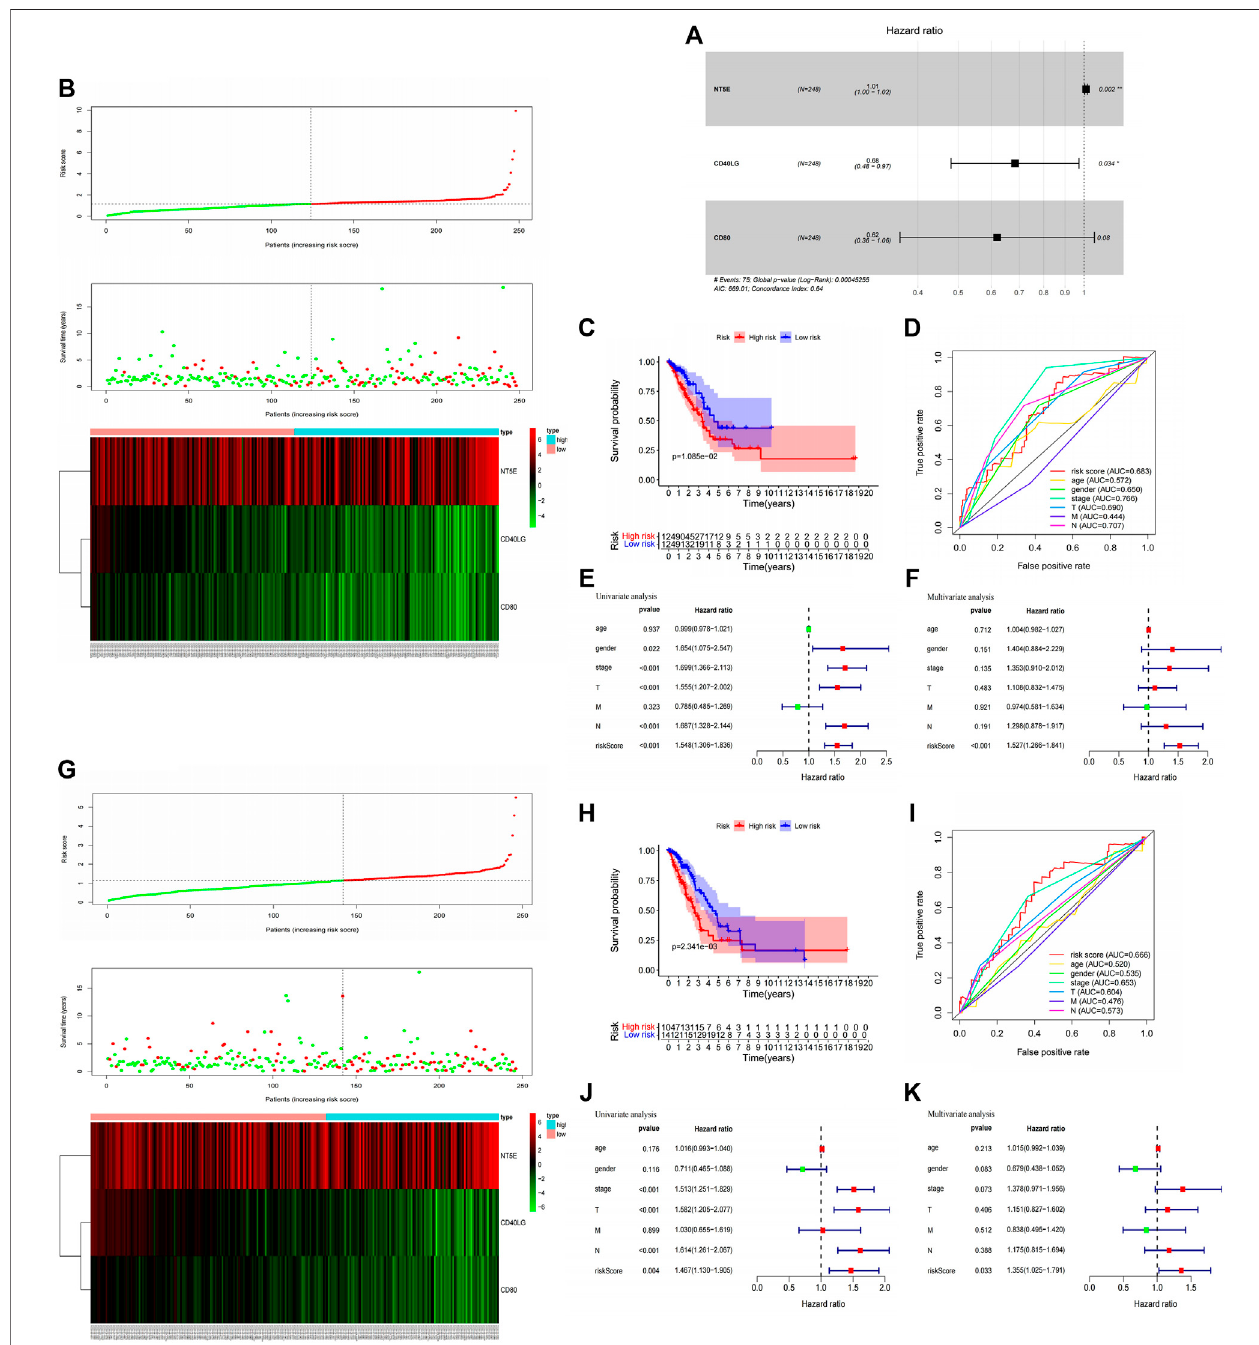
FIGURE 6 | Construction immune signatures based on SLC6A8-associated immunomodulators and predictive evaluation. (A) Stepwise multivariate Cox Proportional hazard regression analyses to screen for three selected candidate immunomodulators ( NT5E, CD40LG, CD80 ) to construct a set of immune signatures. Distribution of risk scores, survival statuses, and gene expression pro fi les for LUAD in (B) the training set and (G) testing set The x -axis of the heatmap represents the samplenumber ofpatientsinthetrainingset ( Supplementary MaterialS2 ) and testing set ( Supplementary Material S3 ) inthe Coxriskproportional regression mode. Comparison of high - and low-risk groups based on model scoring using Kaplan-Meier survival analysis in (C) the training set and (H) testing set. Assesment of Cox risk regression model accuracy using ROC curves in (D) the training set and (I) testing set. Univariate and multivariate Cox analysis combining model scoring with clinical factors to identify independent prognostic indicators in (E,F) the training set and (J) , (K) testing set.